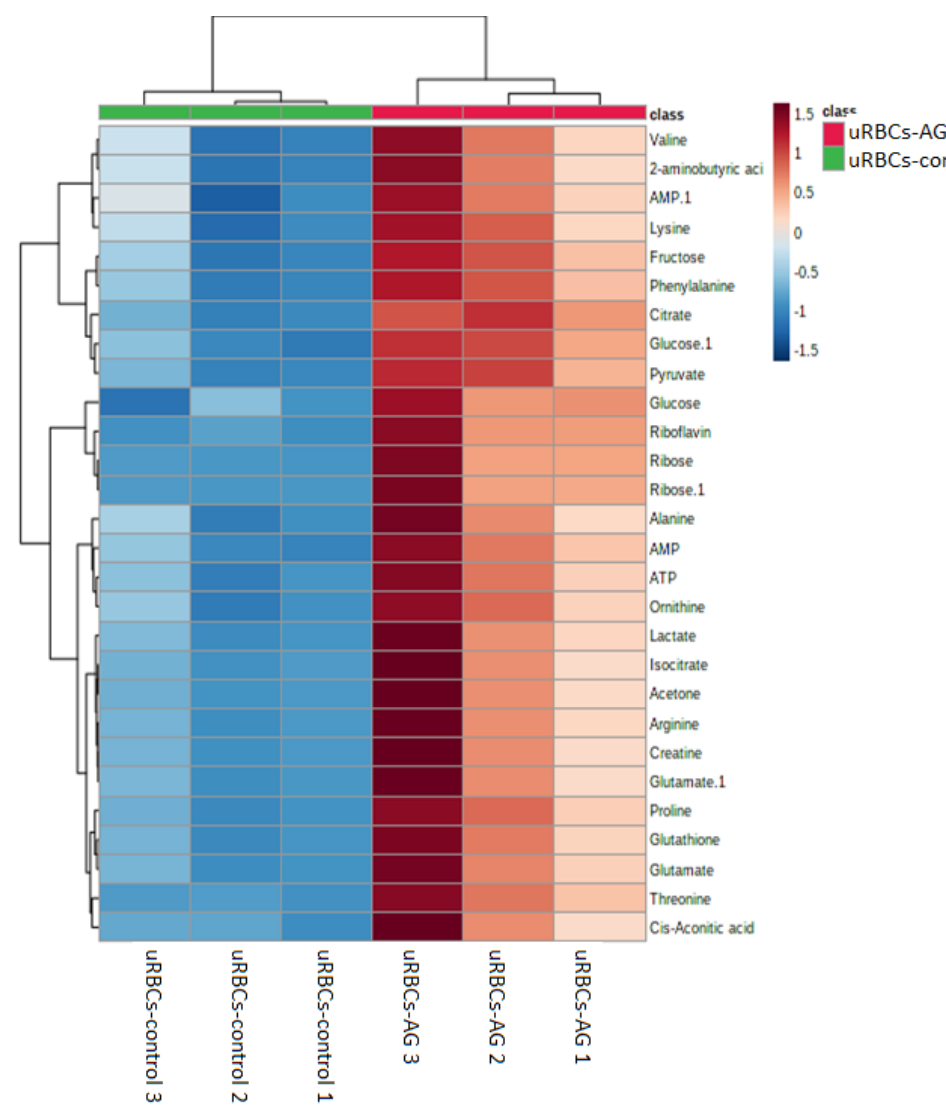
Figure 9. Heat map of the identified biomarkers of uRBCs and uRBCs-AG obtained from HCA by using Ward’s minimum variance method and Euclidean distance. The concentration of each metabolite is colored based on a normalized scale from minimum −1.5 (dark blue) to maximum 1.5 (dark brown). uRBCs, uninfected red blood cells; AG, andrographolide.